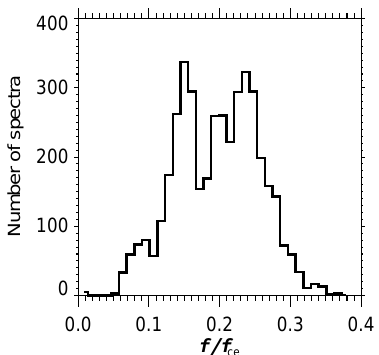
Fig. 4. Histogram of normalized frequencies of maximum power- spectral density for intense chorus events from Fig. 2 occurring at L>